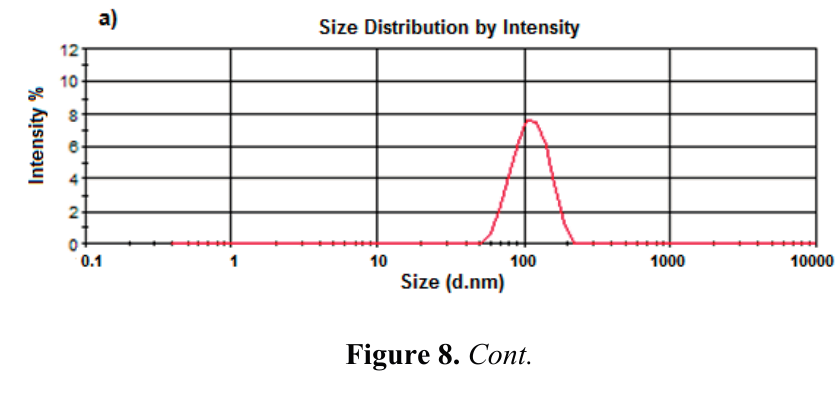
Figure 7. Graphical representation of ( a ) sizes achieved and ( b ) zeta potentials achieved for CPZ-loaded PCL based nanocapsules as per statistical design.